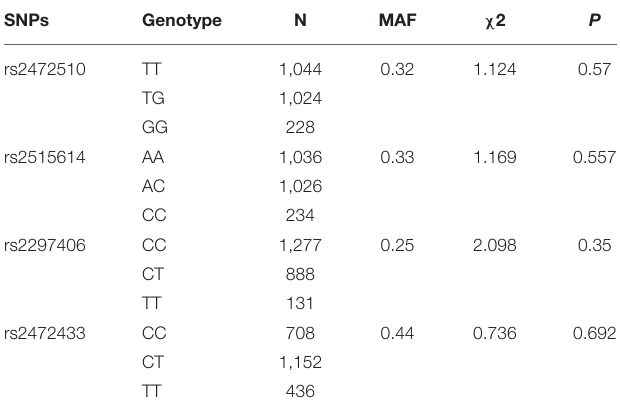
TABLE 3 | Hardy-Weinberg Equilibrium analysis of the ABCA1